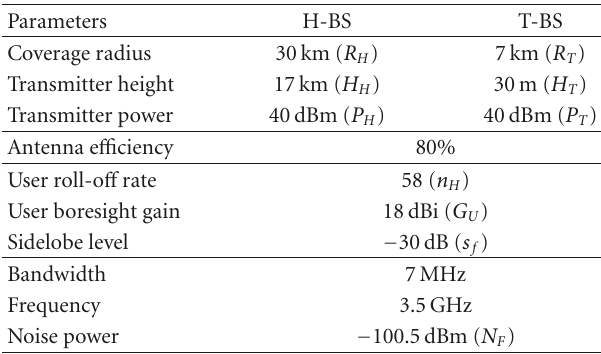
Table 1: Important system simulation